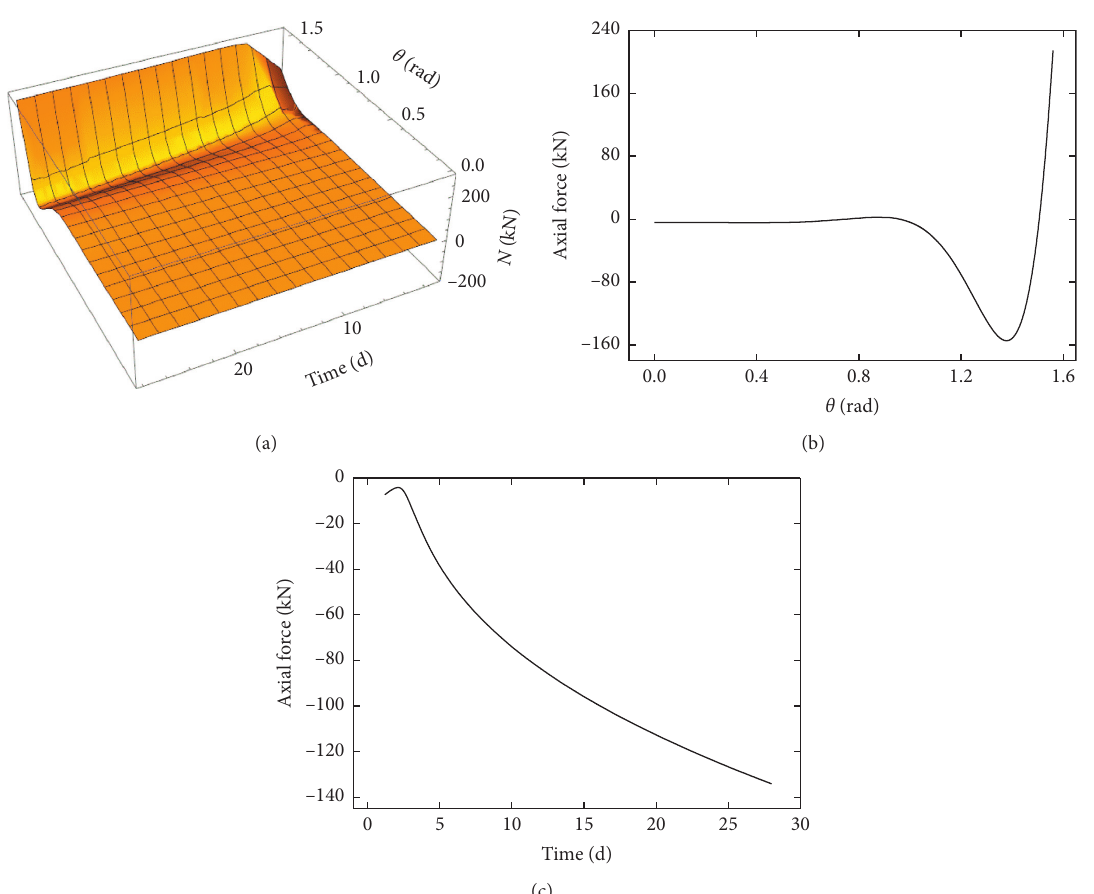
Figure 8: Primary support axial force (kN). (a) Temporal-spatial distribution. (b) t � 28d. (c) θ �